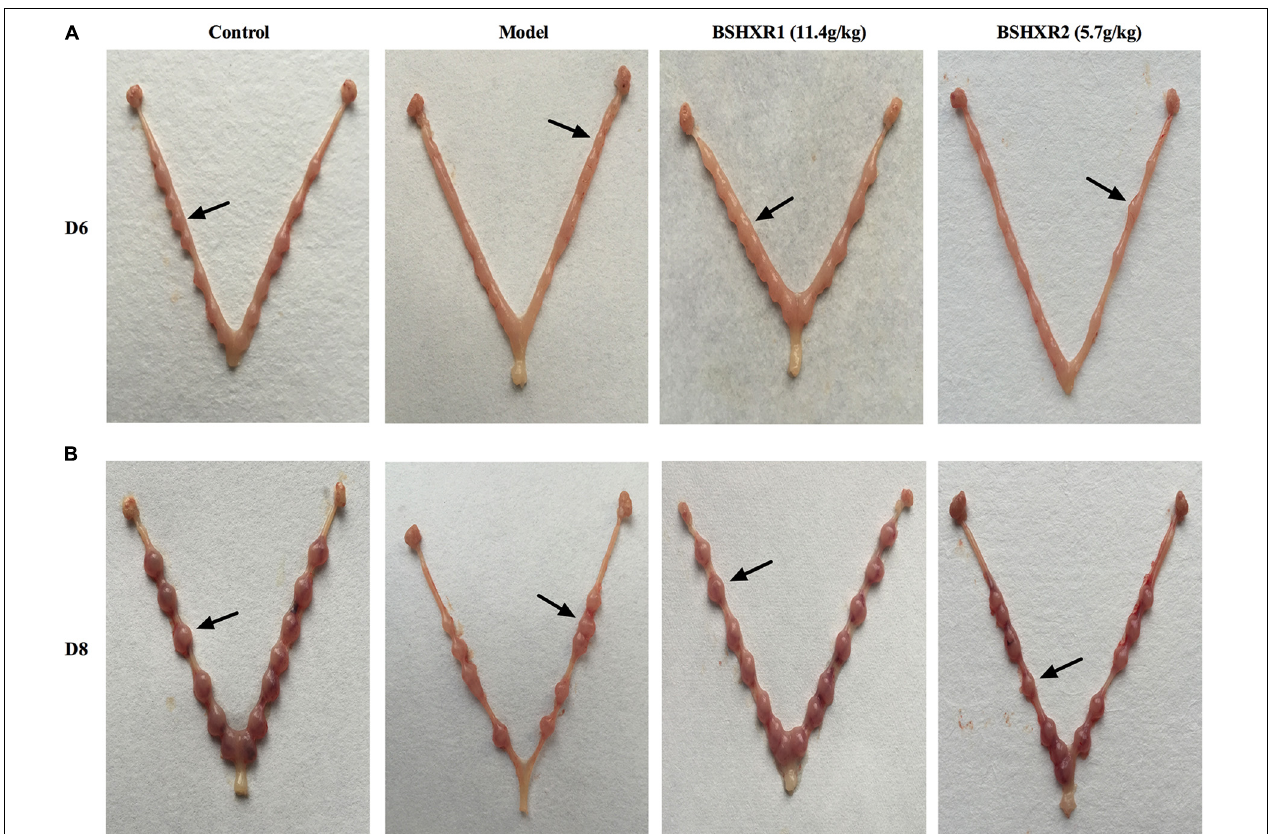
FIGURE 3 | Visible external morphology of uterus showing implantations on D6 (A) and on D8 (B) . Arrows indicate implantation sites.